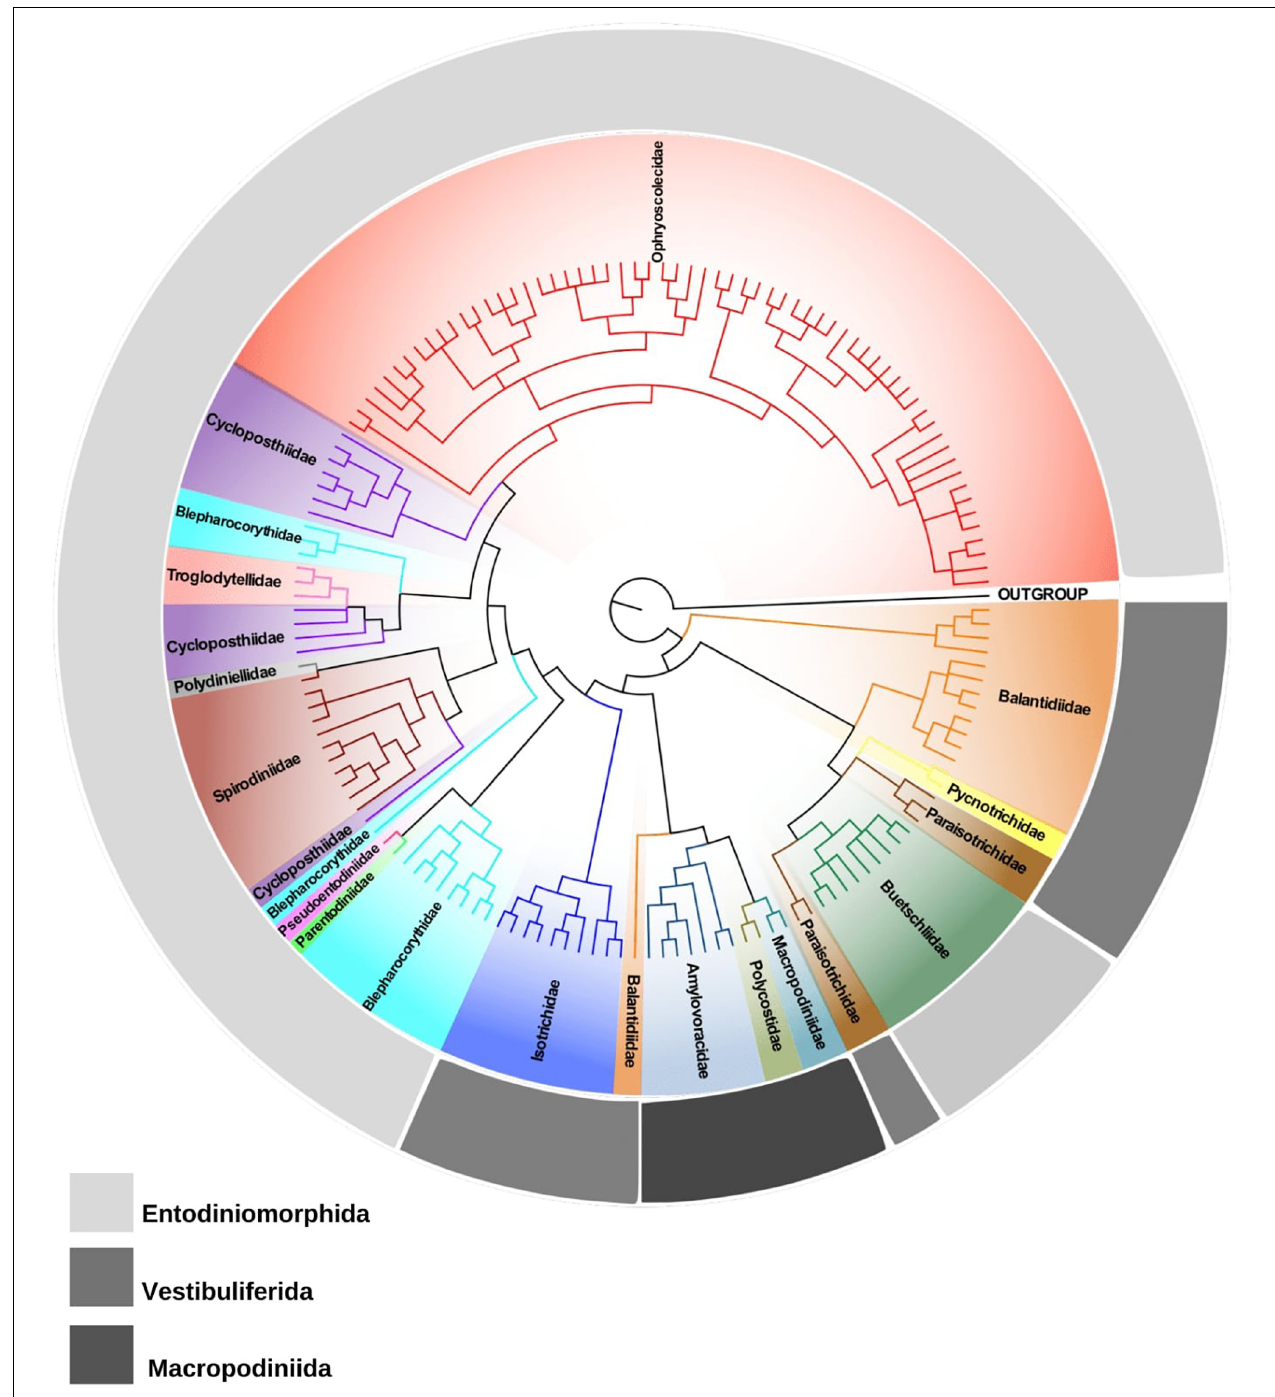
FIGURE 1 | Phylogenetic tree of trichostomatid ciliates (Ciliophora, Litostomatea, and Trichostomatia) estimated by Bayesian Inference and based on 18S rRNA gene data. Spathidium papilliferum was chosen as out group.